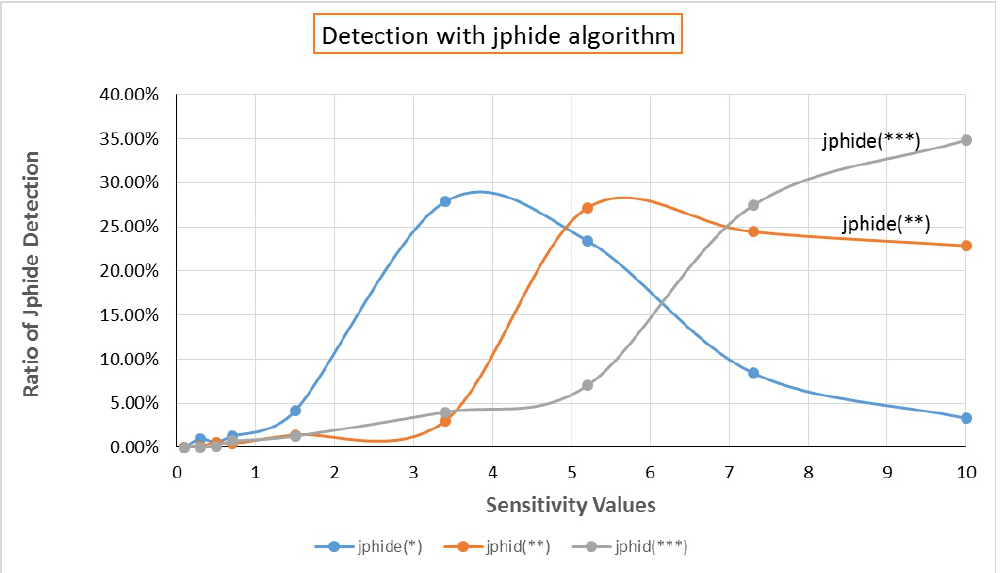
Figure 8. Changes in the jphide rate with different sensitivities for Washington university image database.